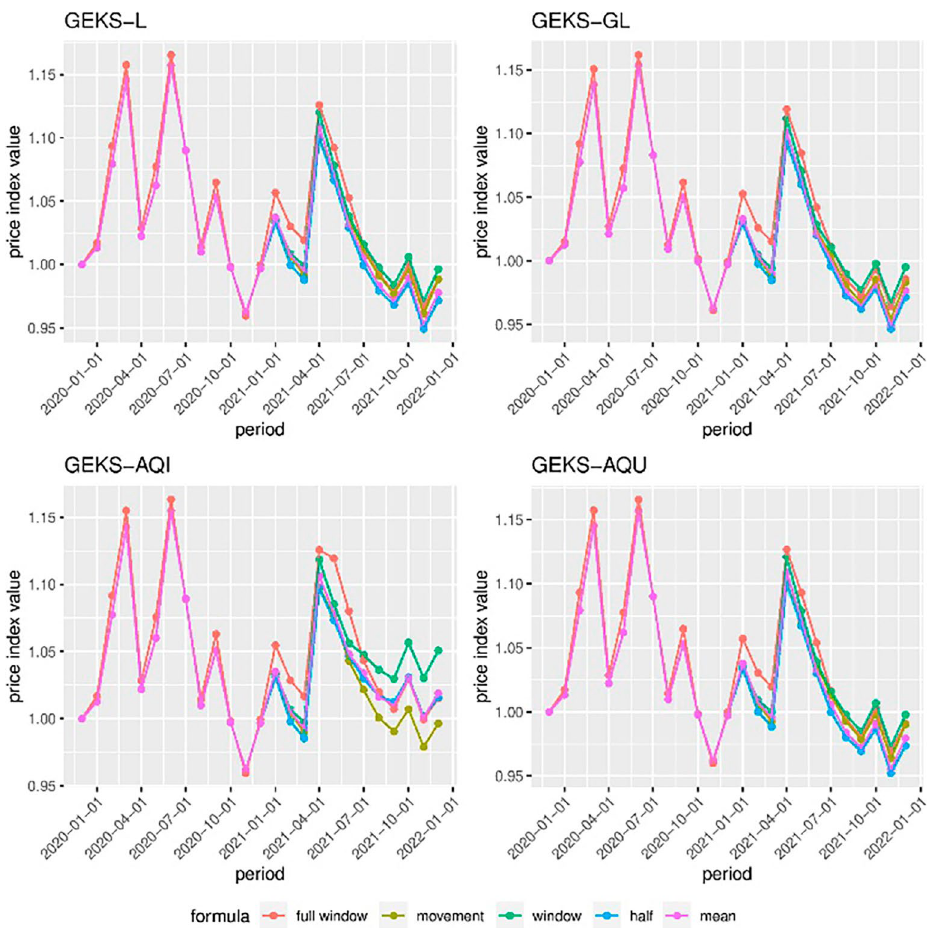
Figure A6. Comparison of G IDT indices (splicing methods vs full time indices) for coffee